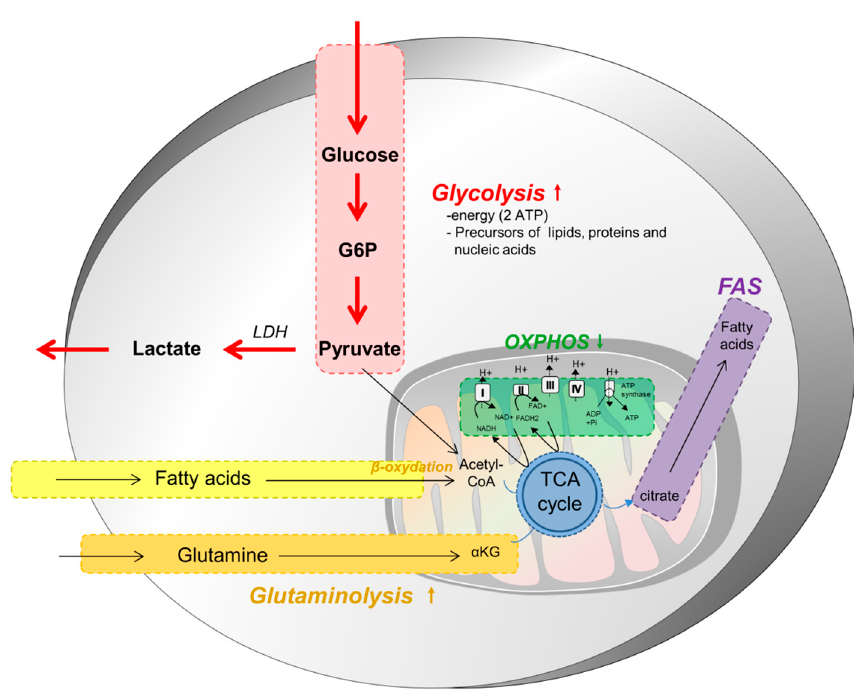
Figure 1. Cancer cell metabolism. Most cancer cells depend on a higher glycolytic metabolism to proliferate and disseminate, regardless of the presence of oxygen. This is made possible through the overexpression of GLUT1, a glucose cell surface transporter. This metabolic switch, known as the Warburg effect, occurs at the expense of the oxidative phosphorylation (OXPHOS) and provides, in a short amount of time, the energy, as well as many precursors of the macromolecules, required to sustain a high rate of proliferation. In cancer cells, pyruvate is largely directed to produce lactate instead of being metabolized within mitochondria. Glutamine and fatty acids constitute two other substrates used preferentially by tumor cells, and which provide intermediates of the tricarboxylic acid cycle (TCA) cycle. They are further used to produce other building blocks for these demanding cells and to maintain some mitochondrial activity and functioning.